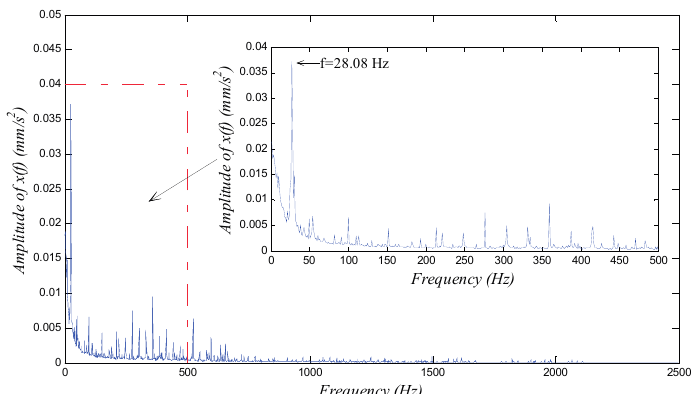
Figure 8. The output global and low-frequency spectrums of generalized parameter-adjusted Duffing system with the vibration signal of sliding-bearing experimental table input. The corresponding parameters in the detection system are set to ε